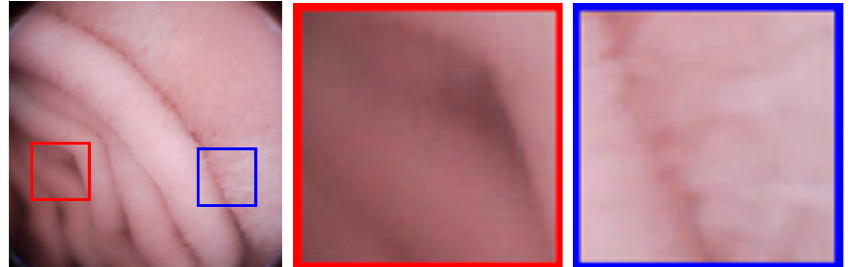
Figure 8. Blocking artifacts demonstration in an image with peak signal to noise ratio (PSNR) = 41.63 dB: Blocking artifacts are more perceptible in flat regions (red framed) than non-flat regions (blue framed).